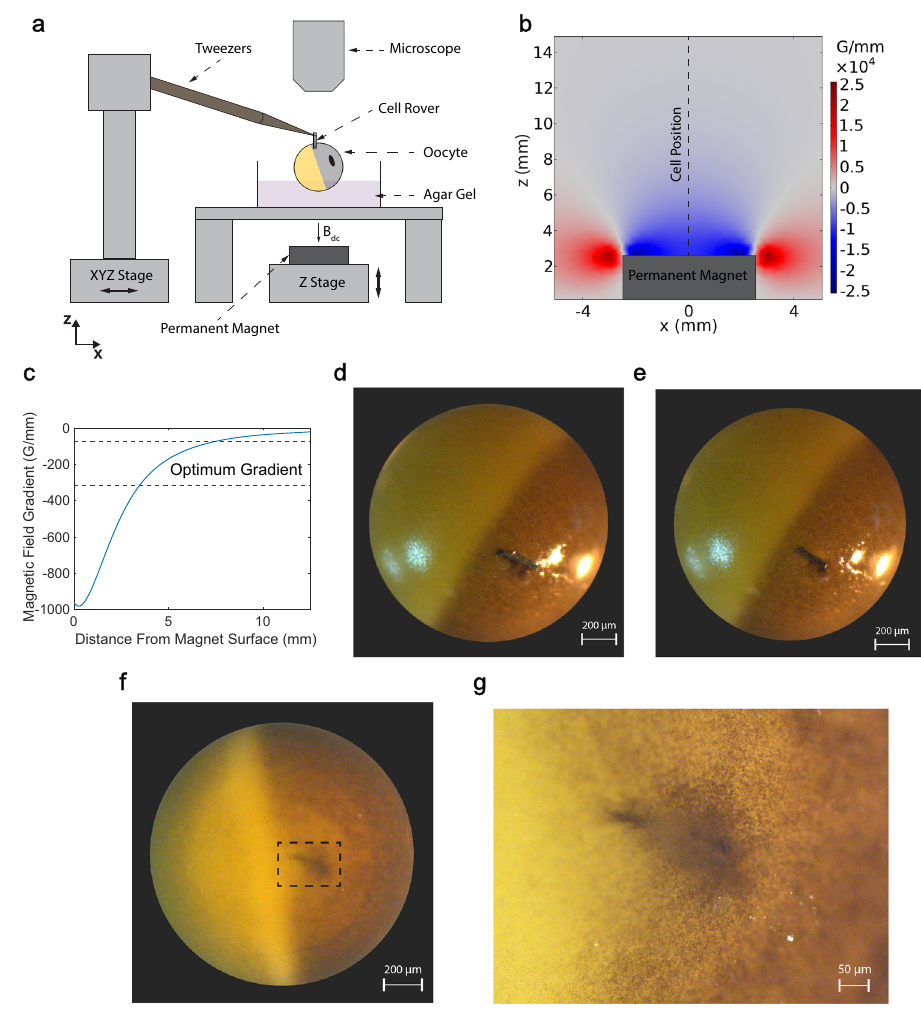
Fig. 3 | Intracellular injection of Cell Rovers. a Schematic diagram showing the setup for injection of Cell Rovers into the cytoplasm of a Xenopus oocyte. The antenna is inserted into the membrane using a pair of tweezers and then pulled into the cell using a permanent magnet. The position of the magnet is controlled using a micromanipulator stage. b FEA simulation of magnetic fi eld gradient around a permanent magnet (Neodymium N52 Bar Magnet with a 5mm×5mm cross section). The dotted line shows the different positions of the cell during injection. c Magnetic fi eld gradient ð ∂ B ∂ z Þ along the dotted line in b as a function of